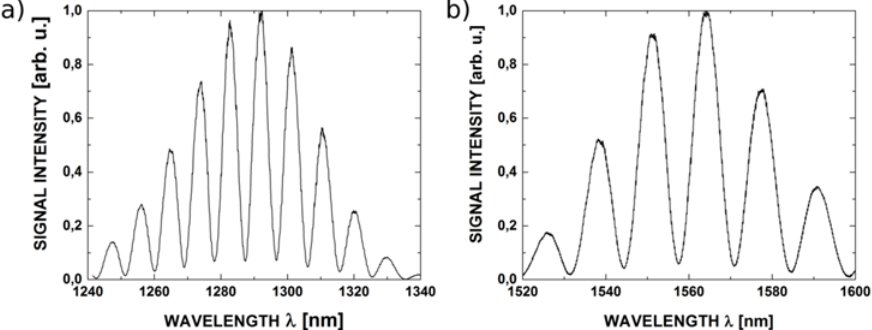
Figure 11. Measured spectra for 50 nm ZnO layers (cavity dimension: 100 µm) for best visibility of the fringes and signal intensity at wavelength ( a ) 1300 nm; ( b ) 1550 nm.